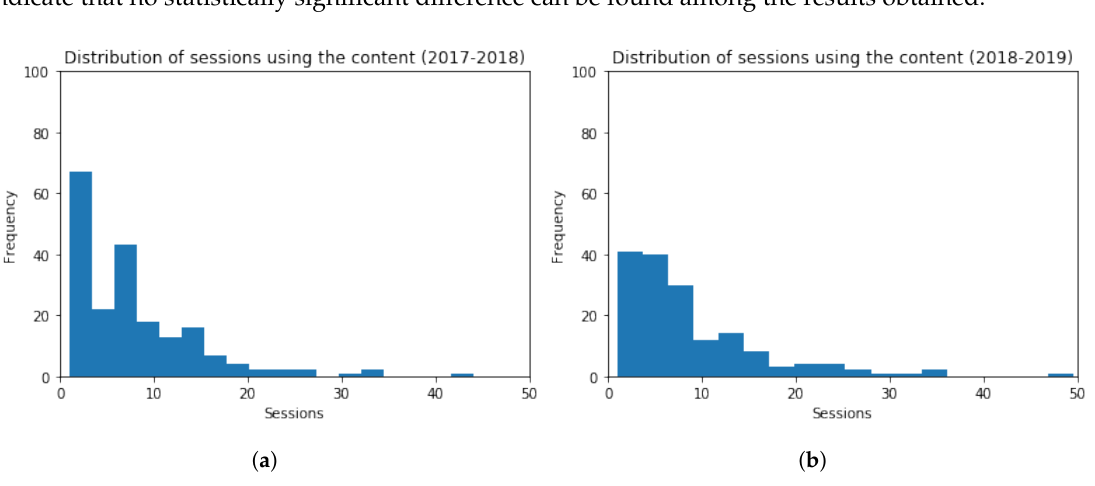
Figure 17. Histogram Graphs for the Number of Sessions in the Contents related to the Activity. ( a ) 2017–2018 ( b ) 2018–2019.